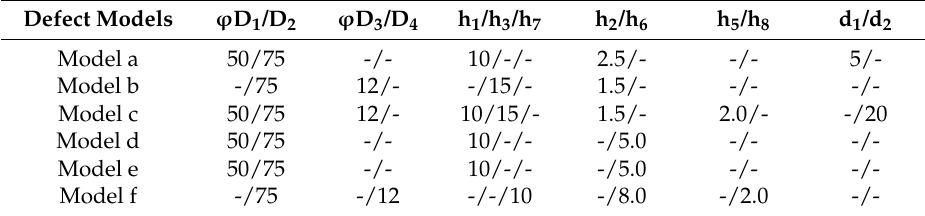
Figure 3. Grounding sketch of the iron core, the red circles represent the places where bad grounding may take place. Table 2. Geometry size of artificial PD models (in mm).